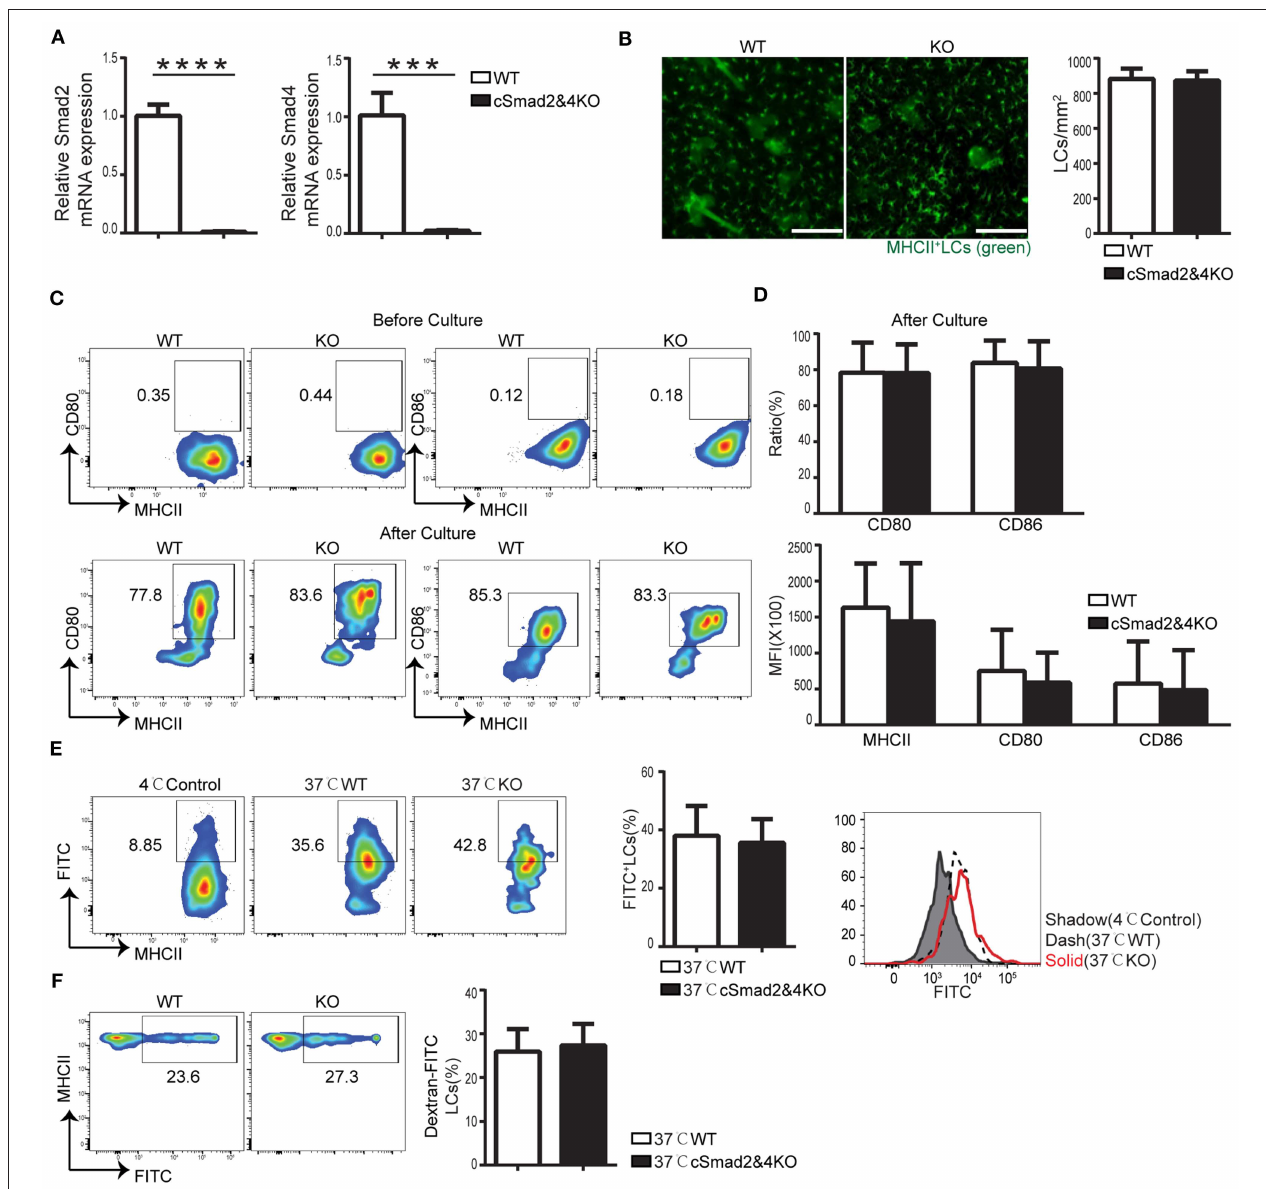
FIGURE 3 | Smad2/4 signaling is not essential for LC homeostasis, maturation, phagocytosis, and migration. In cSmad2&4KO and WT mice, (A) Expression of Smad2 and Smad4 in sorted LCs by qRT-PCR ( n = 6, *** P = 0.0009, **** P < 0.0001). (B) Epidermal sheets at 5 weeks old were stained with anti-MHCII